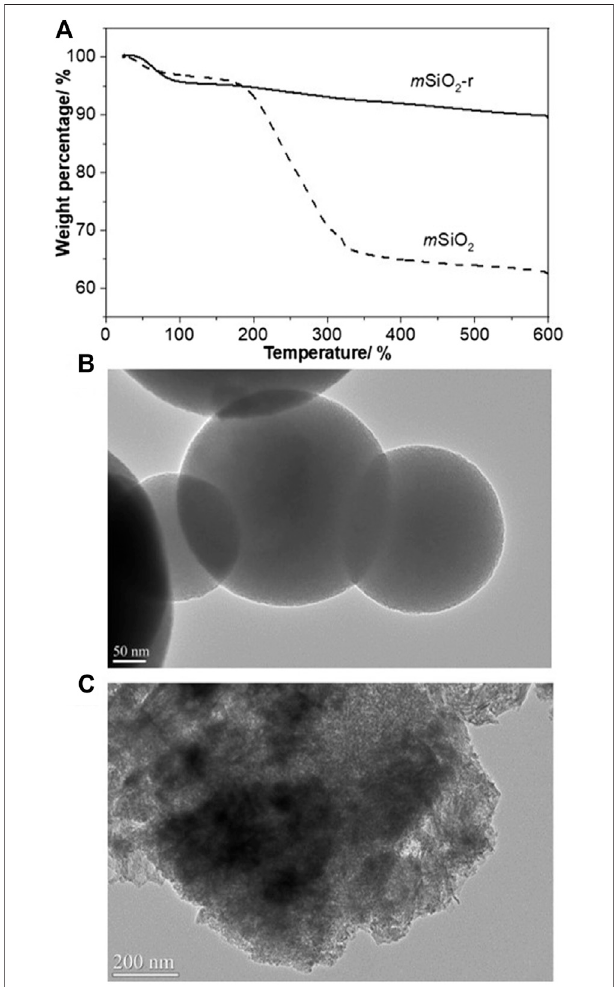
FIGURE 5 | (A) TGA curves of m SiO 2 and m SiO 2 -r, (B) TEM image of m SiO 2 -r, (C) TEM image of m SiO 2 -r after being etched at 0.2 M Na 2 CO 3 at 60 ° C for 10